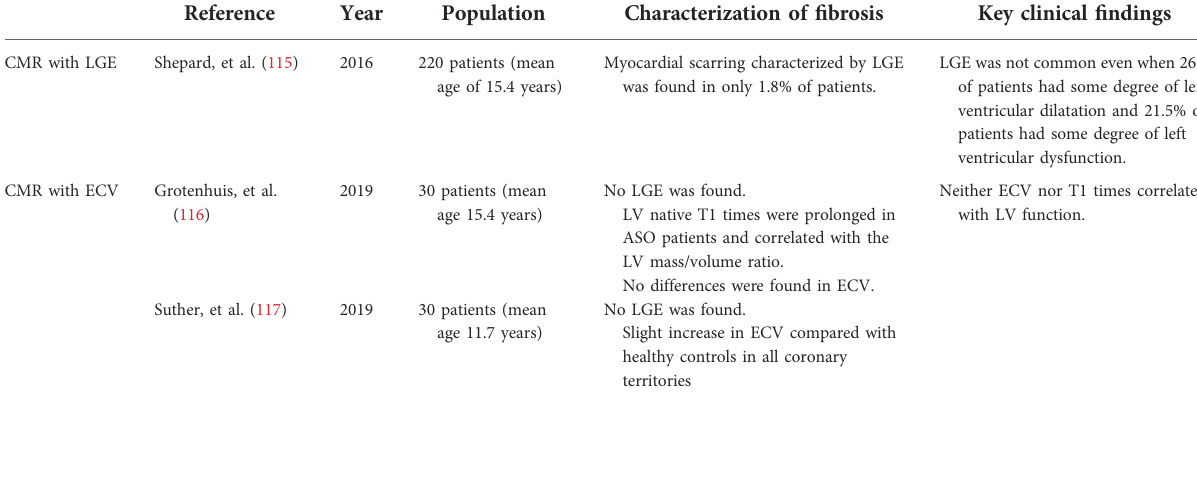
TABLE 3 Most relevant studies characterizing myocardial fi brosis in patients with arterial switch operation.